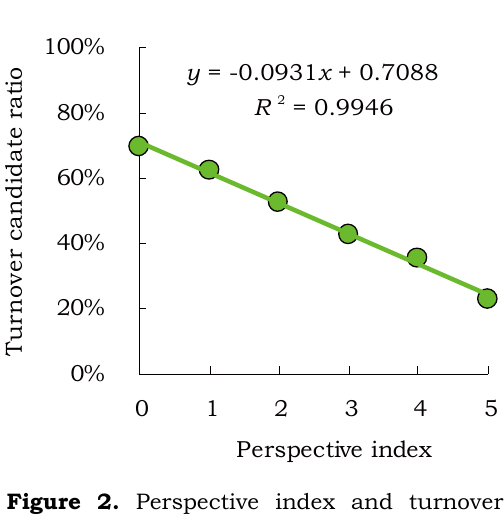
Figure 2. Perspective index and